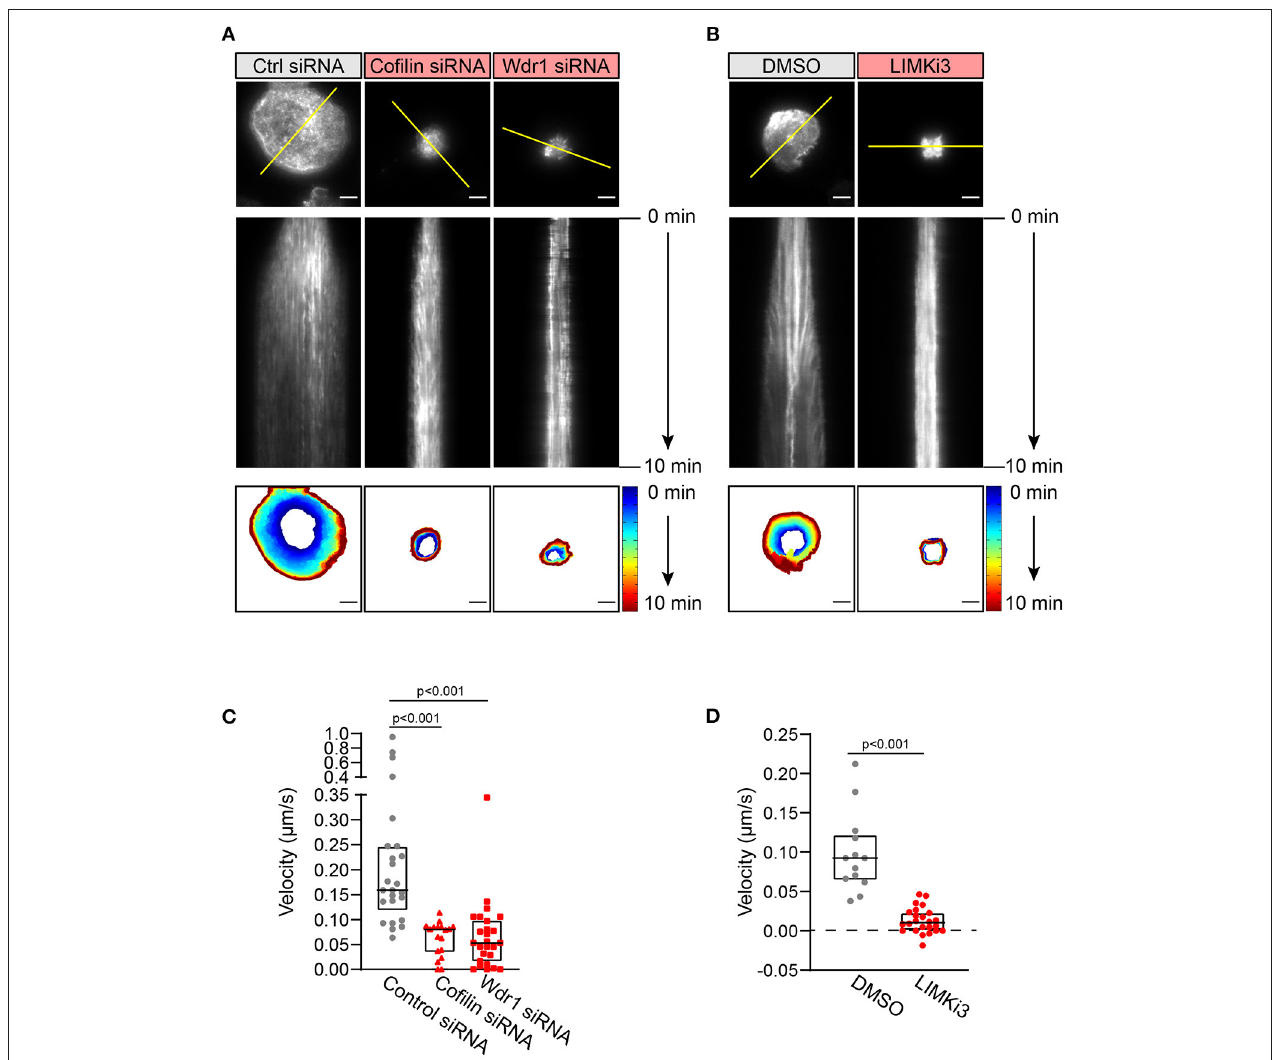
FIGURE 4 | The Wdr1-LIMK-cofilin network is important for BCR-induced actin dynamics. A20 B cells were co-transfected with F-tractin-GFP cDNA and either control (Ctrl) siRNA, cofilin siRNA, or Wdr1 siRNA (A) , or transfected with F-tractin-GFP cDNA and then pre-treated with DMSO or 50 µ M LIMKi3 for 1h (B) . The cells were then added to anti-IgG-coated coverslips and imaged by TIRF microscopy at 1s intervals for 10min. The top panels are the final frames, i.e., 10min time point, from Movie 1 (control siRNA), Movie 2 (cofilin siRNA), Movie 3 (Wdr1 siRNA), Movie 4 (DMSO-treated), and Movie 5 (LIMKi3-treated). The middle panels are kymographs along the yellow lines in the top panels. Static F-actin structures appear as vertical lines. In the bottom panels, the cell edge in each frame, as defined by F-actin staining, was overlaid as a temporally-coded time series. Scale bars: 5 µ m. (C,D) The centripetal velocity ( 1 x/ 1 t) was calculated for individual actin tracks on kymographs. Each dot on the graphs is an individual actin track. For each condition the velocity was determined for 13-26 actin tracks from 5 to 10 cells. The median and interquartile ranges are shown. The Mann-Whitney U test was used to calculate